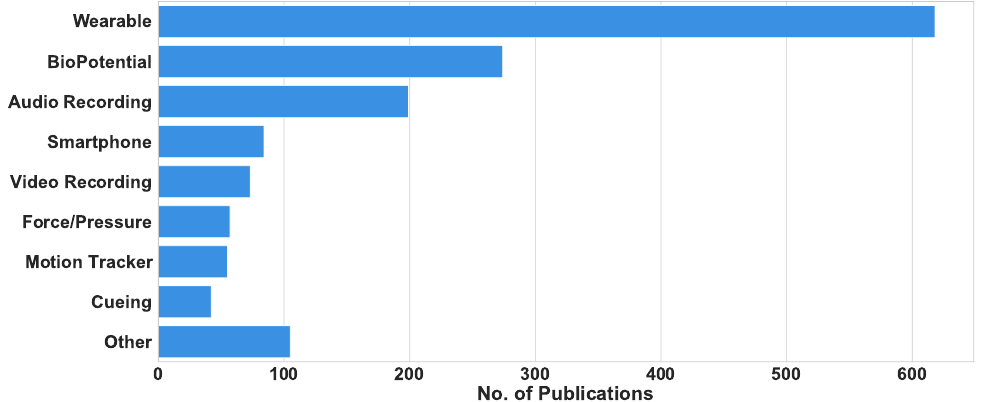
Figure 10. Number of research publications (2008–2021) examining the application of specific types of new technologies to PD areas.